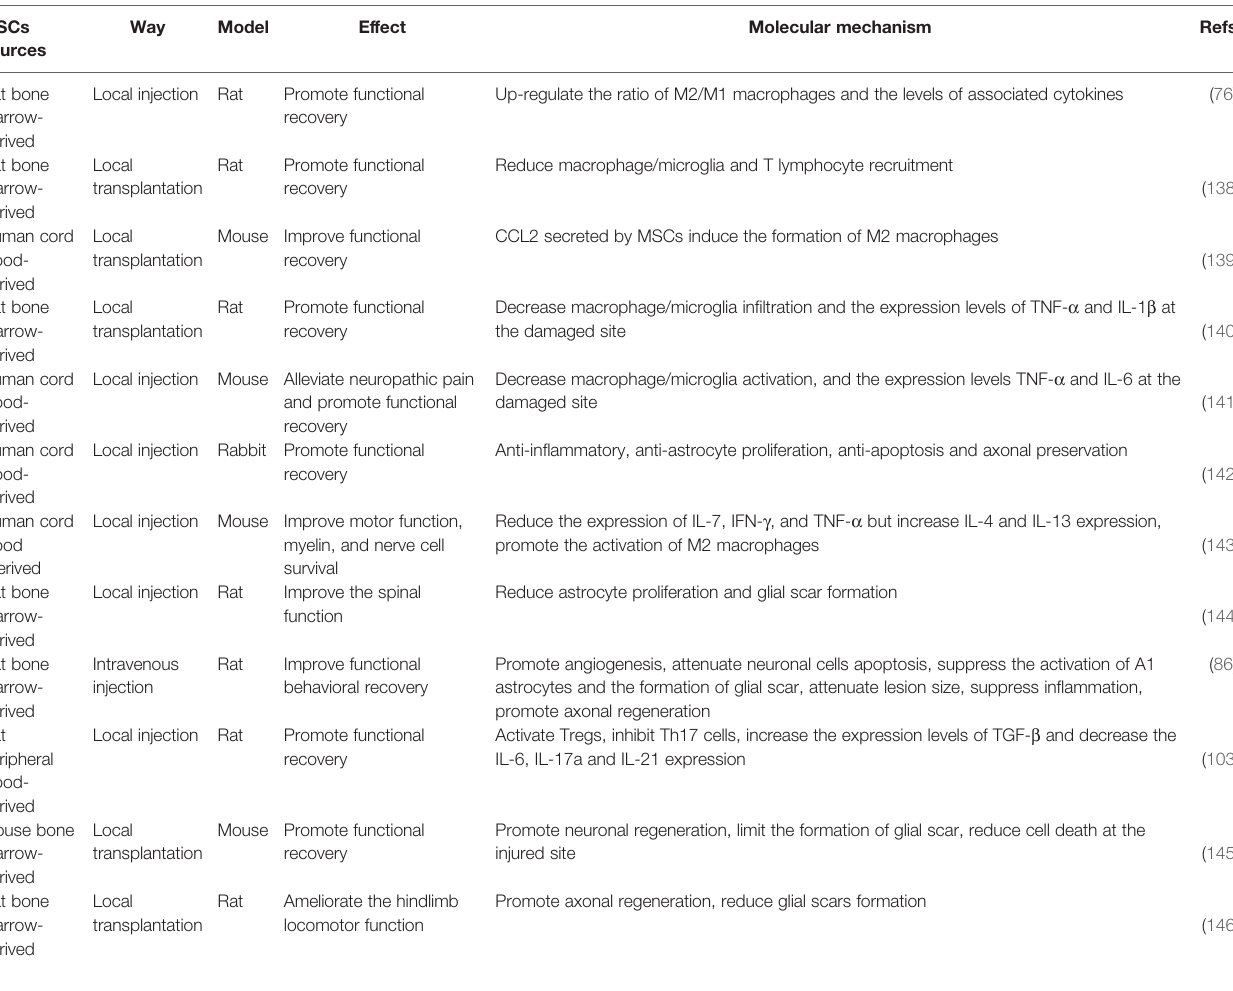
TABLE 1 | Evaluation of MSCs therapy in SCI